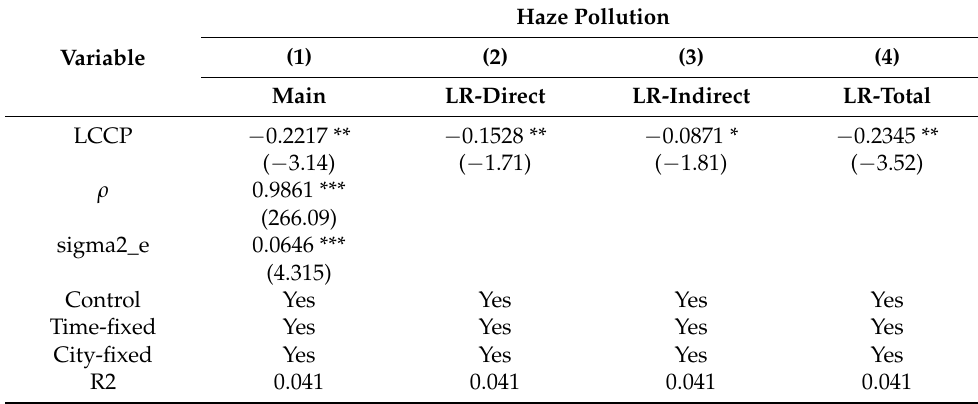
Table 12. Spatial econometric estimation and decomposition results.